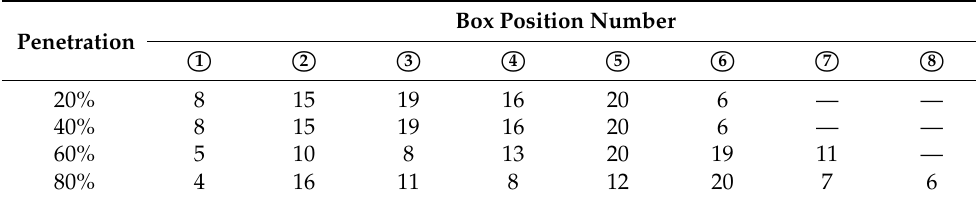
Table 3. Number and position of commutation switches.